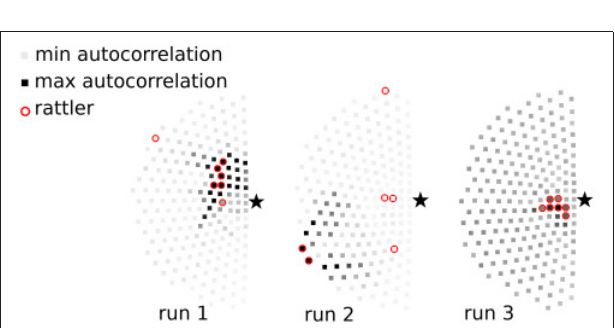
FIGURE 6 | Heuristic identification of rattlers through their auto-correlation time 1 t *. Each SPP is shown as a square and shaded according to 1 t *. In runs 1 and 3 the SPPs with the highest auto-correlation time are also identified as rattlers by the threshold method (red circles, ξ r 4). In run 2 this heuristic is = less successful at identifying rattlers near the center of the